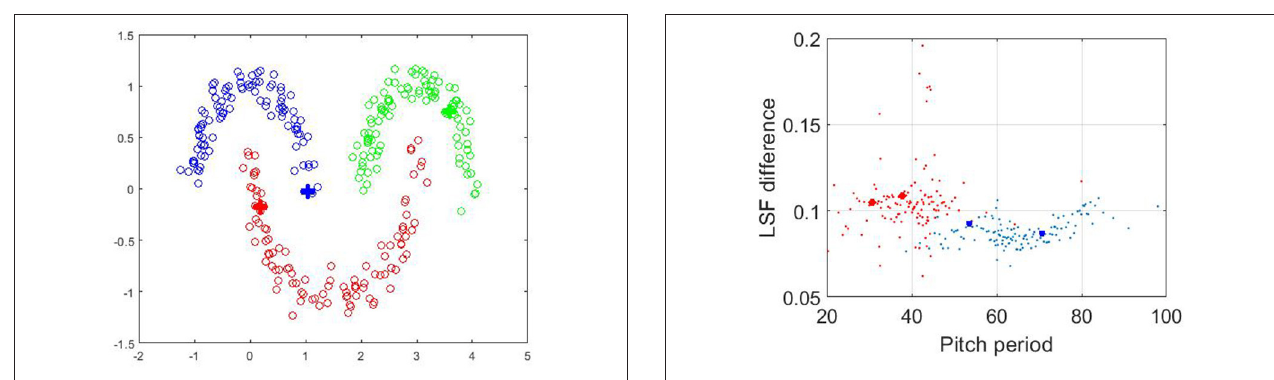
FIGURE 9 | The distribution of 128 considered vectors for male (blue color) and female (red color) speakers. The four labeled points are marked.